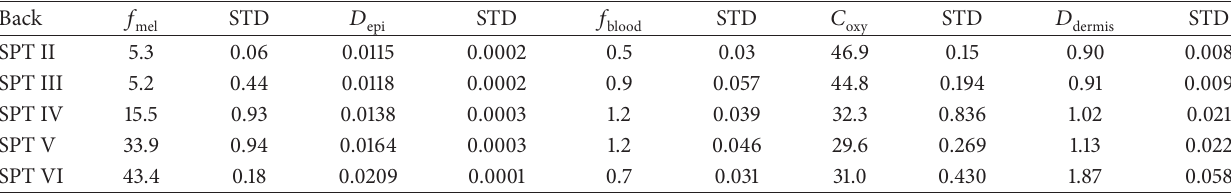
Table 5: Back parameters estimation for SPT II, III, IV, V, and VI.